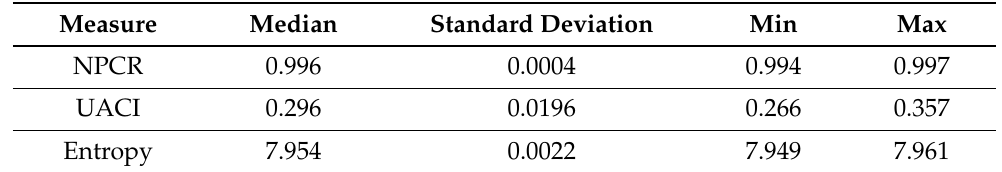
Table 4. Metrics: median, standard deviation, minimum and maximum of 145 images for NPCR, UACI, and Entropy using CASIA dataset.